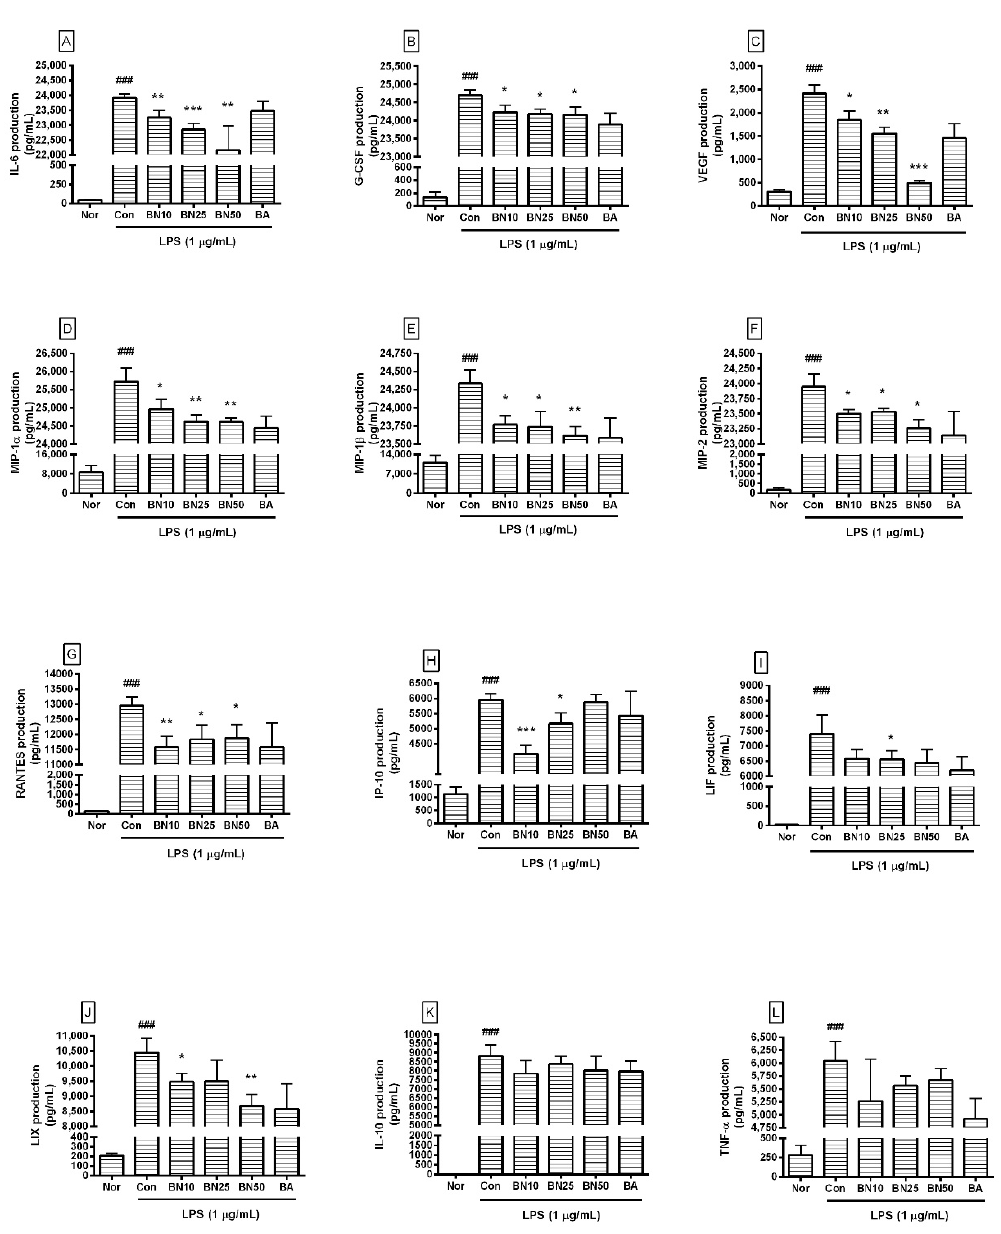
Figure 4. Production of IL-6 ( A ), G-CSF ( B ), VEGF ( C ), MIP-1 α ( D ), MIP-1 β ( E ), MIP-2 ( F ), RANTES ( G ), IP-10 ( H ), LIF ( I ), LIX ( J ), IL-10 ( K ), and TNF- α ( L ) in RAW 264.7. Values are presented as mean ± SD of three independent experiments. Nor, normal group incubated with media only; Con, control group treated with 1 µ g/mL of LPS only; BN10, BN25, and BN50 are 10, 25, and 50 μ M of baicalin, respectively; BA, baicalein (25 µ M). ### p < 0.001 vs. Nor; * p < 0.05 vs. Con; ** p < 0.01 vs. Con; *** p < 0.001 vs. Con.